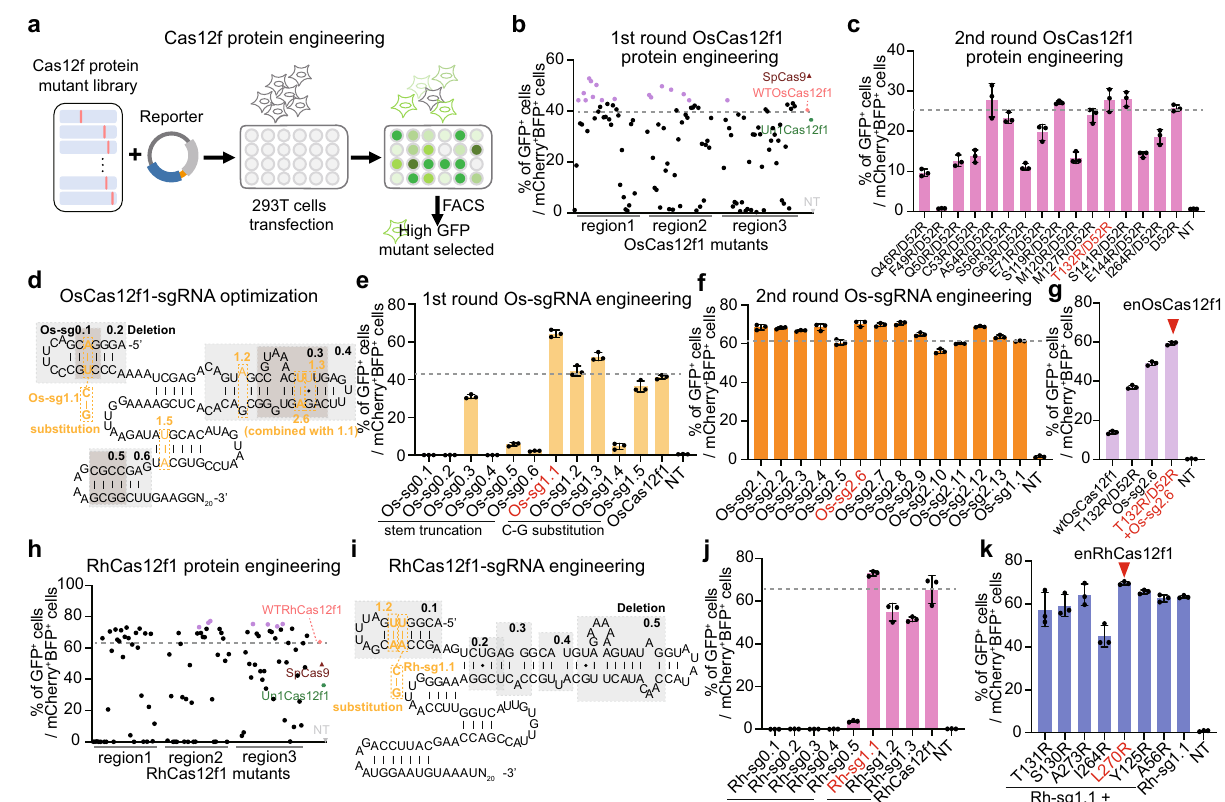
Fig. 2 | Rational protein engineering and sgRNA optimization for high- ef fi ciency Cas12f1. a Scheme of protein engineering strategy. Mutants showing higher EGFP activation were selected for further optimization. b The fi rst round high-ef fi ciency mutant screen of OsCas12f1. The wild-type OsCas12f1 (WTOs- Cas12f1),Un1Cas12f1_ge4.1,SpCas9, and themutant selectedfor next round screen are indicated. Target sequence (PAM-20nt protospacer): TTTC- CCATTACAGTAGGAGCATAC. c Secondround enhancedOsCas12f1variantsscreen by combining D52R with other arginine substitution mutants. Target sequence (PAM − 20nt protospacer): TTTC-tttccctagggtccagcttcaaat. Values and error bars represent mean and s.d. ( n =3). d Engineering strategy for stem-loop deletion of OsCas12f1 sgRNA. e sgRNA engineering for OsCas12f1. The optimal sgRNA (Os- sg1.1),whichwaschosenforfurtherengineering,ismarkedinred.Targetsequence (PAM − 20nt protospacer): TTTC-CCATTACAGTAGGAGCATAC. Values and error bars represent mean and s.d. ( n =3). f Second round sgRNA engineering by